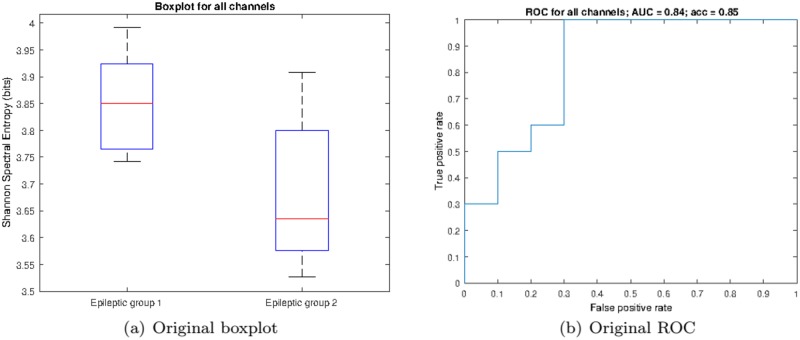
Classification analysis based on all significant electrodes.(a) Boxplot and (b) ROC curve corresponding to the classification analysis of the two groups of epileptic patients. Red lines in the boxes mark the median and edges the 25th and 75th percentiles of the data.